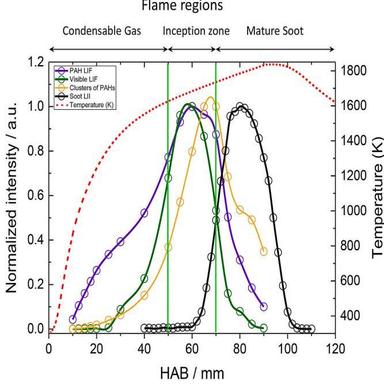
Normalized LIF profiles of the 3 different of types of fluorescent species determined by EEM (colored solid lines) and LII profile (black solid line) reported from Ref. as a function of the HAB along the central vertical axis of the flame. PAHs LIF corresponds species of type 1, Visible LIF corresponds to species of type 2 and clusters of PAHs corresponds to species of type 3. The temperature profile (red dashed line) has been reported from.